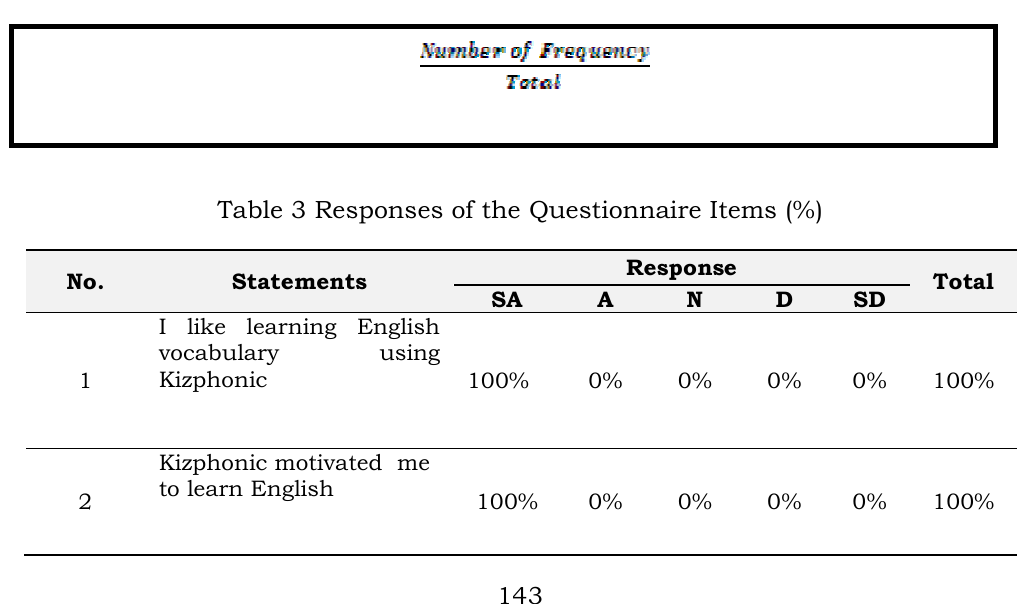
table 2. In analyzing the data, the researcher calculates the percentage computation. The formula of the computation is as follows: